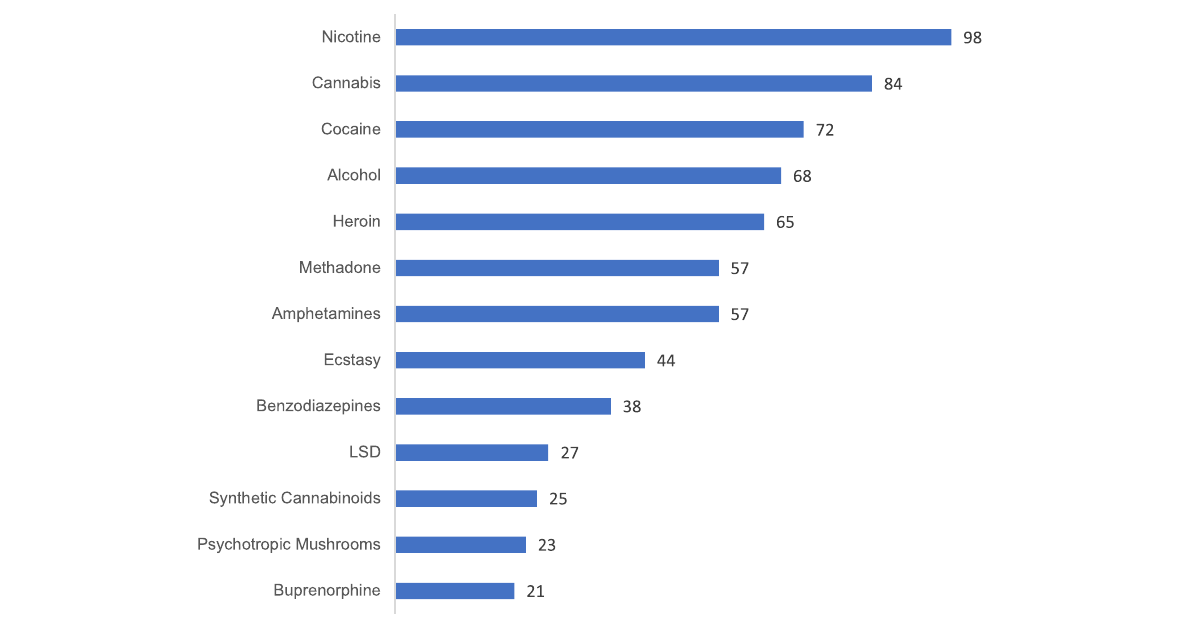
FIGURE1 Number of ratings made by user cohort 1, per substance. The minimum number of ratings required for inclusion of a substance was determined as n = 20. Extended version in Supplementary Figure 15